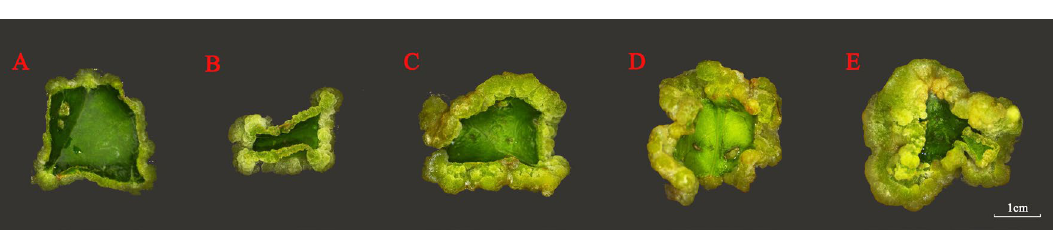
Figure 8. Different developmental stages of O. fragrans callus. Callus at ( A ) 25 days, ( B ) 45 days, ( C ) 55 days, ( D ) 65 days, and ( E ) 75 days of